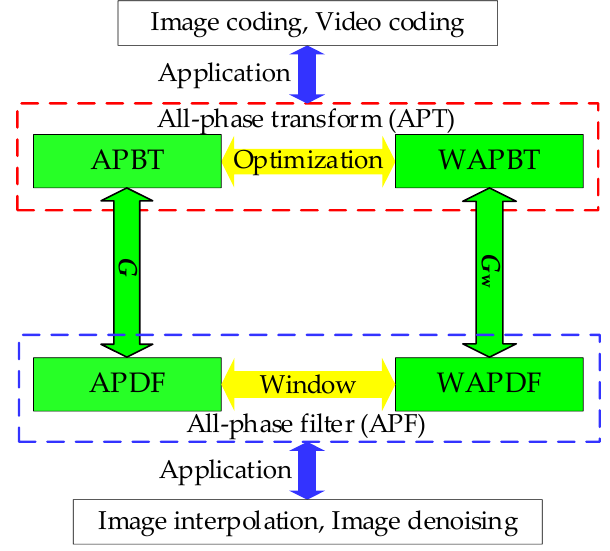
Figure 4. Diagram of APT derived from APDF theory.